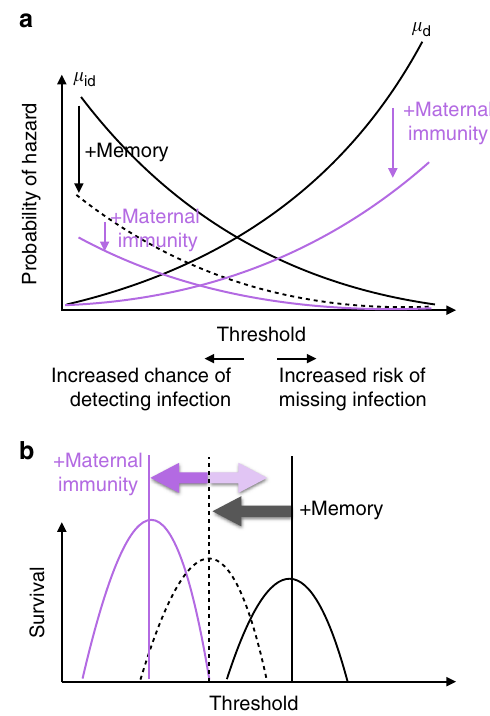
Fig. 4 Conceptual map of the impact of memory and maternal immunity on sensitivity threshold. a The threshold de fi ning the discrimination trade-off ( x axis, high sensitivity to the left, and speci fi city to the right) affects the probability that an individual experiences different mortality hazards ( y axis). Assuming that the pathogen trait that the host is using for discrimination occurs evenly across the x axis, the probability of infectious disease related mortality ( μ d , increasing black line) increases with the threshold used to distinguish “ self ” (left) from “ non-self ” (right), because more infections are missed. Conversely, the probability of hazards arising during an appropriate immune response ( μ id declining black line) increases as the threshold declines, since more pathogens are detected. Memory (black arrows) reduces the probability of μ id , if previously seen pathogens elicit reduced self-destructive immunological activity (dashed black line); maternal immunity (purple arrows) both protects offspring from pathogen related disease in their fi rst year of life, thus reducing the probability of μ d (increasing purple line), and might spare offspring effects associated with μ id (decreasing purple line). b The threshold that maximises survival ( axis) will re fl ect the minimum of the sum of μ d and μ id , accounting also for immunopathology μ i and the balance across different life stages (see Supplementary Figure 5). While memory should reduce the optimal threshold, the impact of maternal immunity will depend on the relative magnitude of the two hazards (likewise, here illustrating a decrease, but with the faded purple arrow to indicate that an increase is also